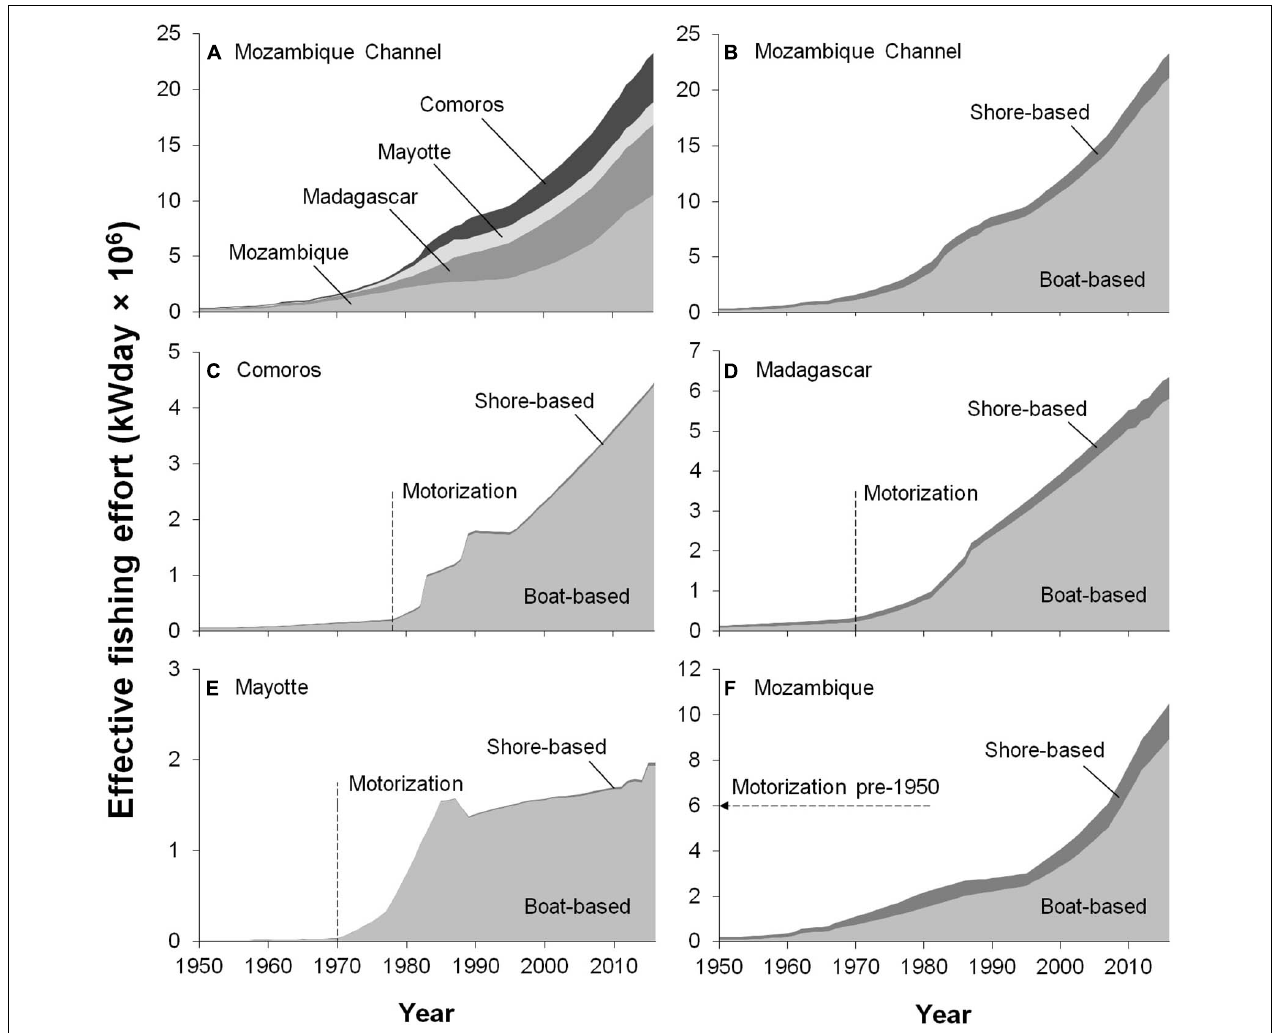
FIGURE 2 | Annual effective fishing effort (kWday × 10 6 ) between 1950 and 2016 for small-scale fisheries in (A) the Mozambique Channel region by country; (B) the Mozambique Channel region by boat- versus shore-based fisheries; (C) Comoros; (D) Madagascar; (E) Mayotte; and (F) Mozambique. Start year of motorization is indicated.